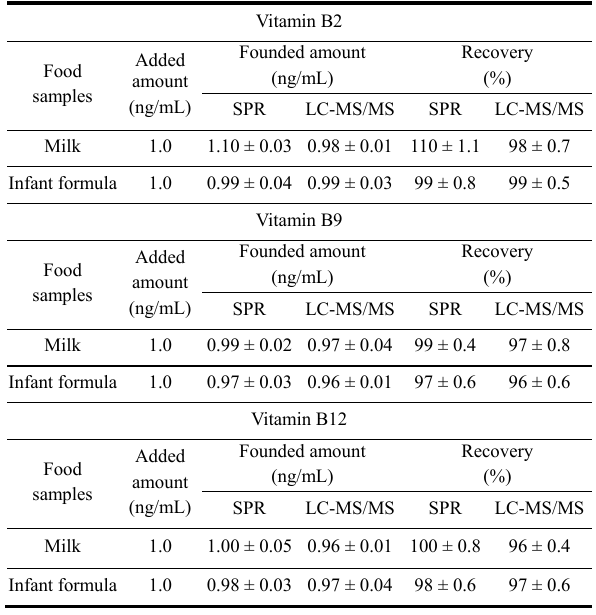
Table 4 Recoveries of vitamins B2, B9, and B12 in food samples ( n